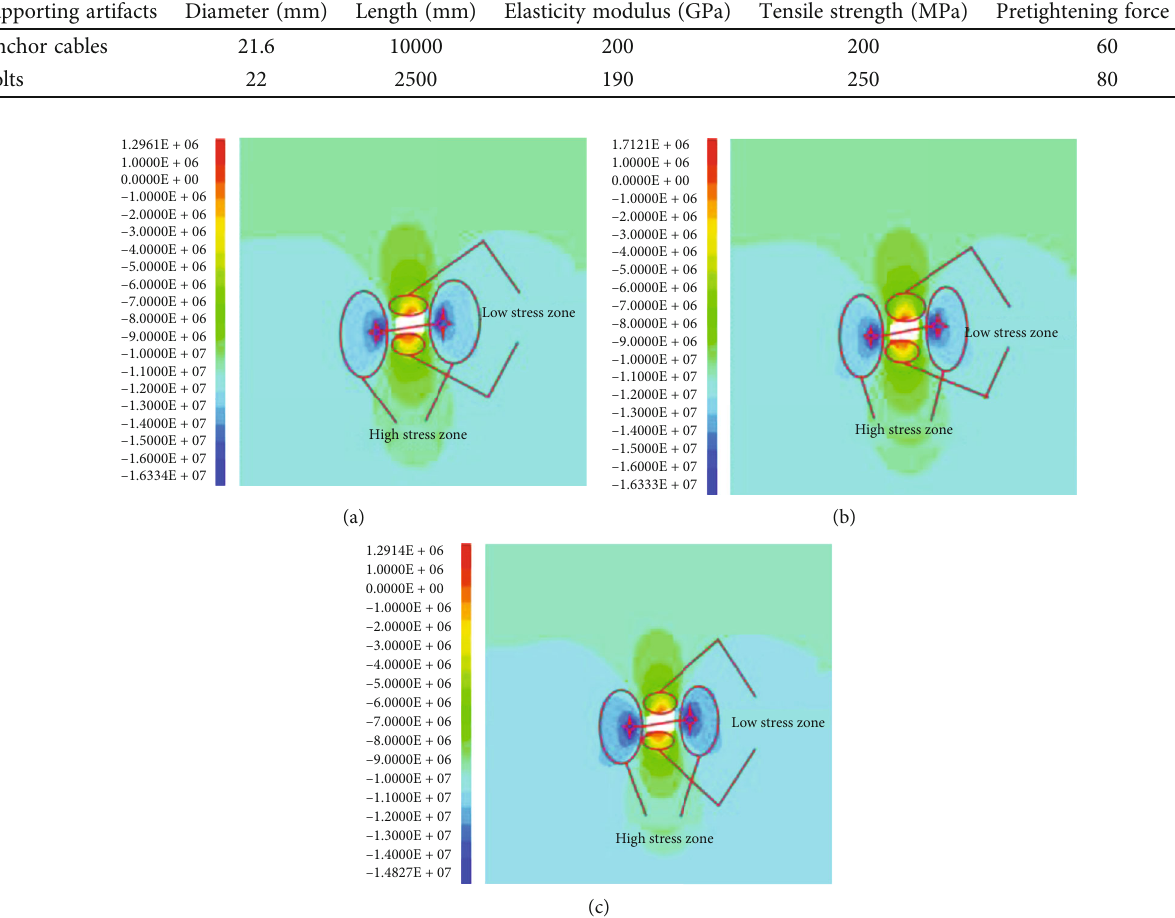
Figure 6: Vertical stress nephogram under di ff erent support methods. (a) No support. (b) Original support. (c) Combined